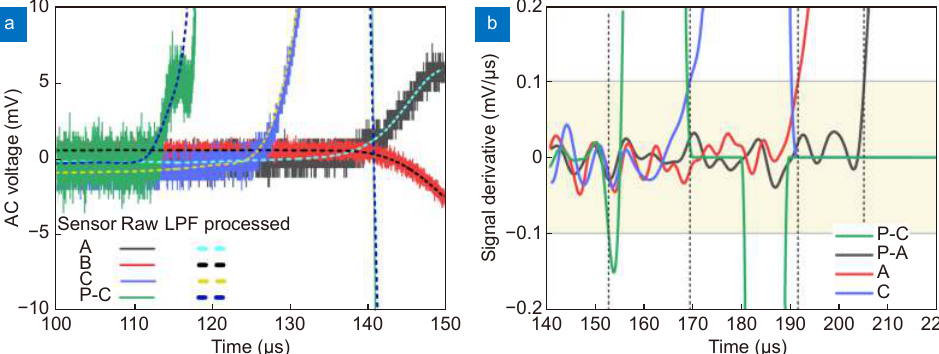
Fig. 11 | ( а ) Signals from FBG-FPI sensors (A, B and C) and one PD (P-C), as well as their variants processed with a low-pass filter, when hit- ting point T2. ( b ) The derivatives of the signals processed by a low-pass filter when hitting point T2 for measuring the speed of sound. The yellow area shows the corridor, the crossing of the boundaries of which indicates the arrival of the wavefront in the sensor area; intersection points are shown with vertical dashed